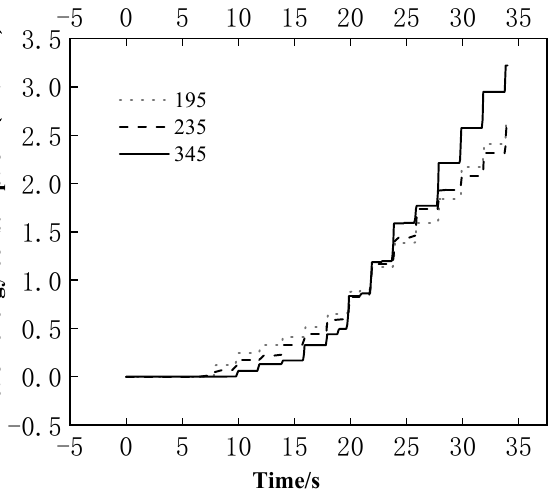
Figure 18. Cumulative energy dissipation curve under different energy dissipation ring strengths.